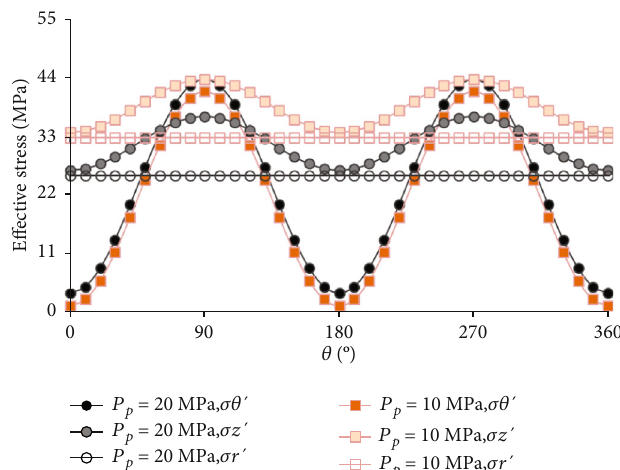
Figure 1: Change of the e ff ective stress state around vertical wellbore with reservoir depletion. The initial reservoir pressure is 20 MPa, and the current pressure after reservoir depletion is 10